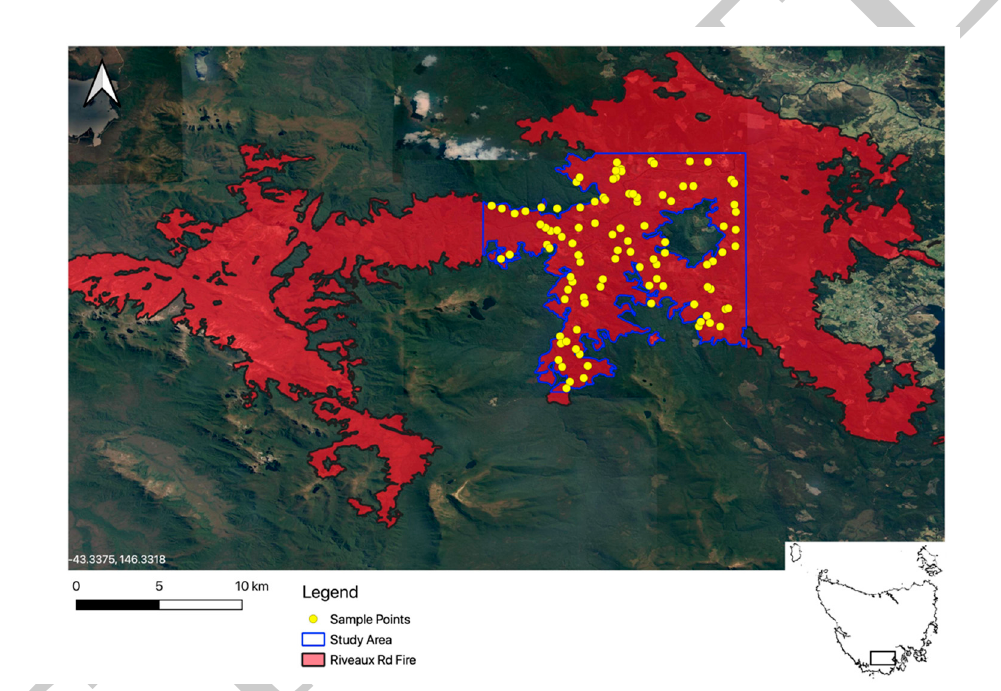
Figure 1. Study area and sample sites in the Huon Valley in southern Tasmania and the fire footprint of the Riveaux fire which burned in January–February 2019.